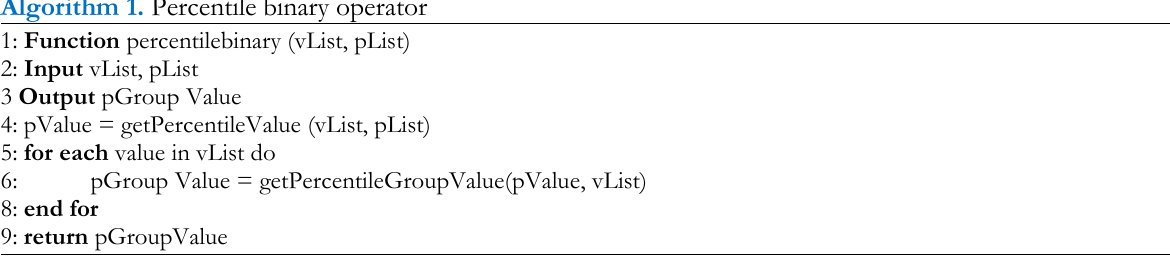
Algorithm 1. Percentile binary operator